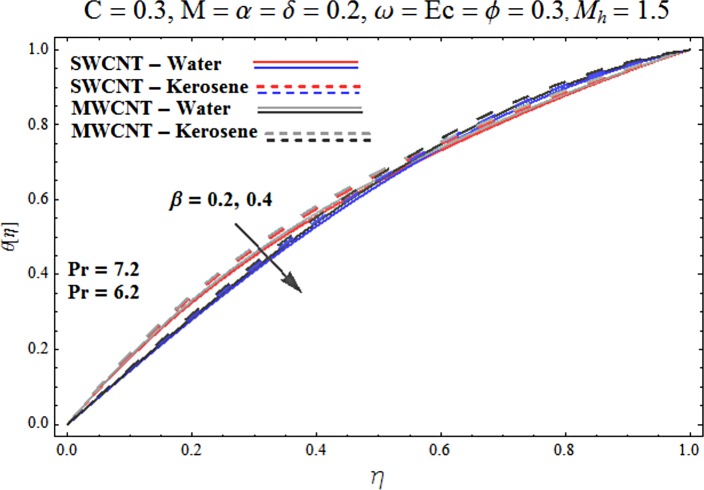
Effect of β on θ.